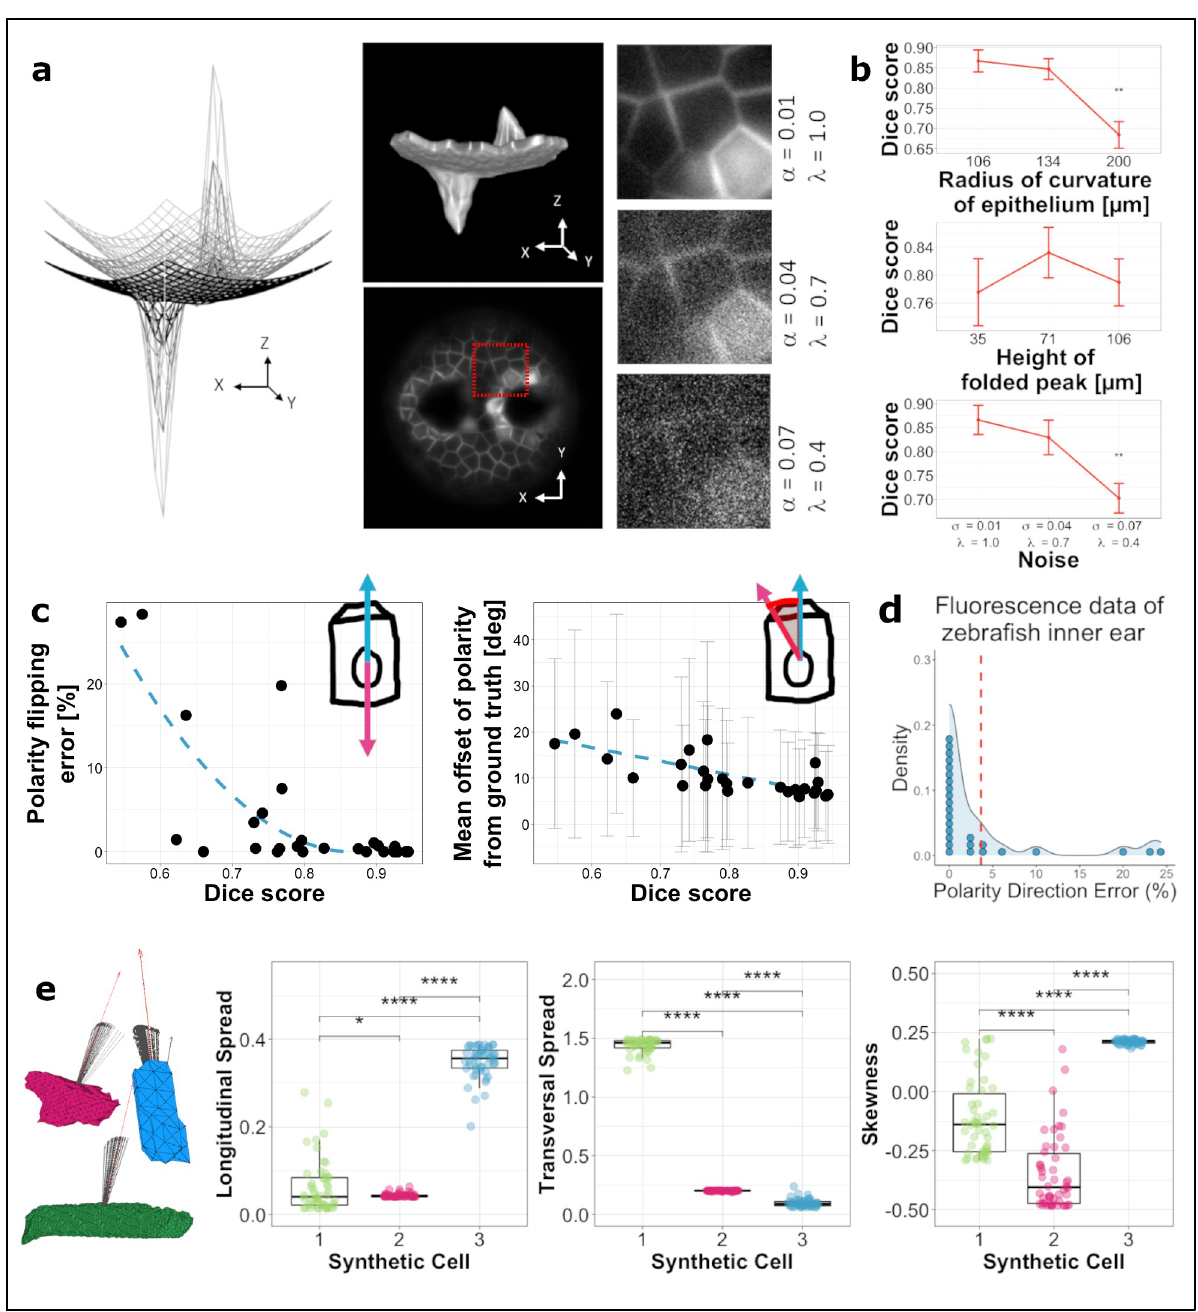
Fig 2. Assessment of polarity assignment. a. Surface meshes of synthetic epithelia for validating the Origami analysis pipeline. Alongside, 3D rendering of one of the synthetic epithelia (top) and a single 2D slice through it (bottom). Each image volume was corrupted with three levels of noise. b. The relationship between surface geometry/noise and segmentation quality. Error bars represent the standard deviation. Tukey’s pairwise comparisons with significant values depicted with asterisks: Dice score at radius of curvature of 200 μ m (1000 pixels) compared to that at 106 μ m (530 pixels)– p = 0.0004, Dice score at largest noise level compared to the lowest: p = 0.0045. c. Effect of segmentation quality on errors in orientation flipping (left) and direction offset in the computed polarity vectors (error bars in grey represent standard deviation). Dashed lines represent quadratic and linear fit to data respectively. d. Probability density of errors in polarity direction in real fluorescence data from zebrafish embryos. Each dot represents the percentage error from a 3D segmented volume (n = 27; total of 949 segmented cells across all the images). The dashed line shows the mean error in the dataset ( < 4%). e. Sensitivity of cell shape metrics to errors in polarity orientation. Data points in the graphs are depicted with the same colour as the corresponding synthetic cell alongside. Tukey’s pairwise comparisons with significant values depicted with asterisks; Longitudinal spread: 1–2 p = 0.039, 1–3 p < 0.0001, 2–3 p < 0.0001; Transversal Spread: 1–2 p < 0.0001, 1–3 p < 0.0001, 2–3 p < 0.0001; Skewness: 1–2 p < 0.0001, 1–3 p < 0.0001, 2–3 p < 0.0001.